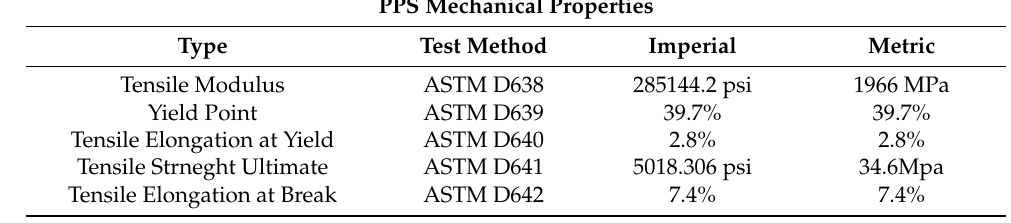
Table 2. PPS technical data sheet.